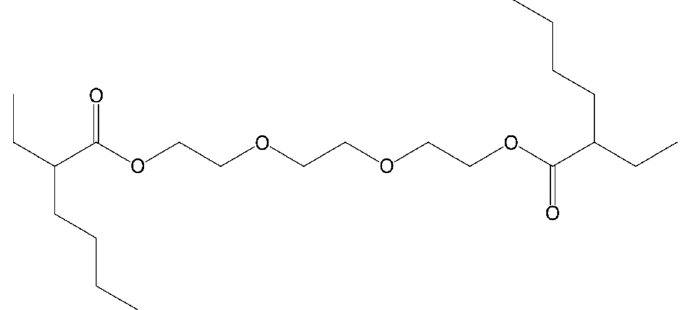
Figure 4. Molecular structure of softener 3G8 [29].